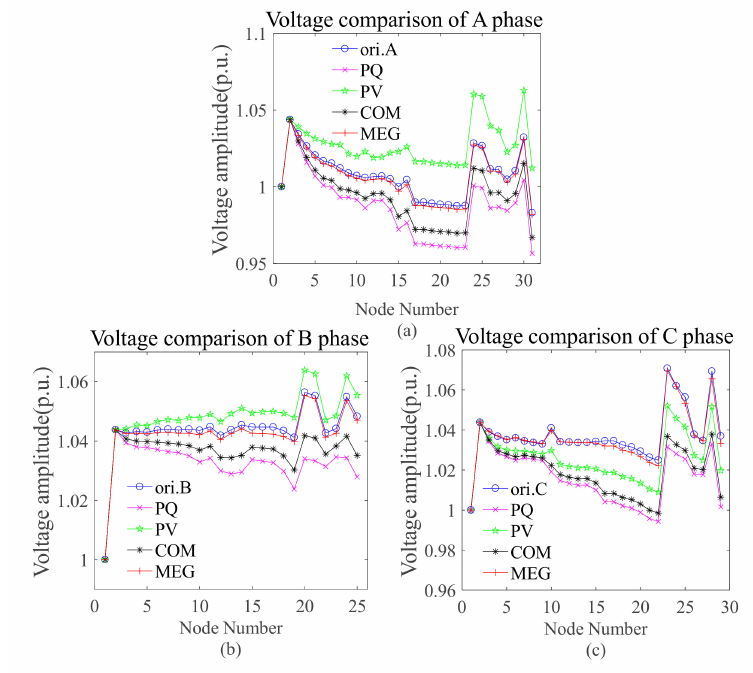
Figure 11. Three-phase voltage static simulation using di ff erent models in Scenario 1.